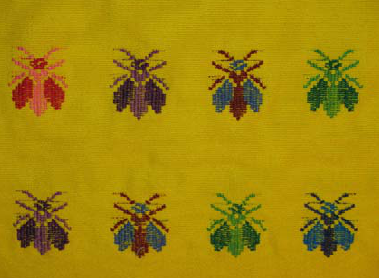
ductive isolating mechanisms that occur after mating but before